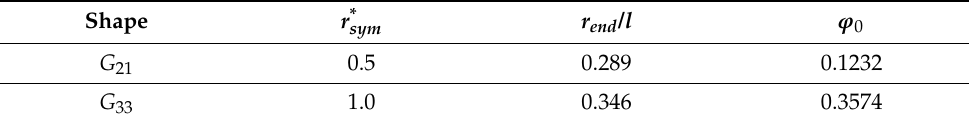
Table 1. Ligament shapes used for the generation of two data sets in the low and a high solid frac- tion regime, respectively.